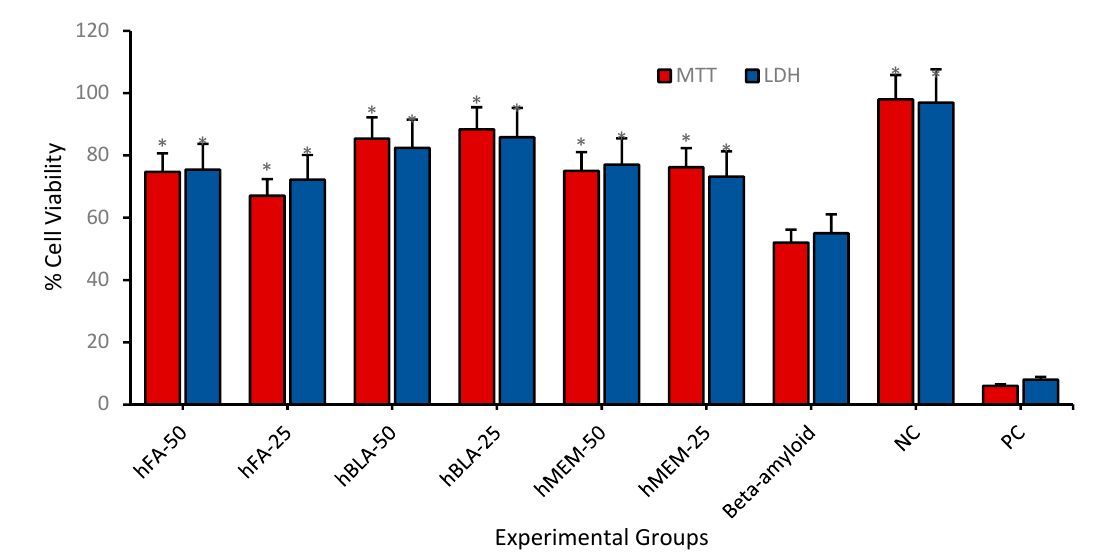
Figure 13. Cell viability tests (MTT and LDH assays) hBN-FA, hBN-FA+BLA, hBN-FA+MEM and β -amyloid (50 µg/mL and 25 µg/mL) on the experimental AD model for 24 h. Symbol (*) represents significantly increased cell viability ( p < 0.0001) compared to only beta-amyloid applied groups.